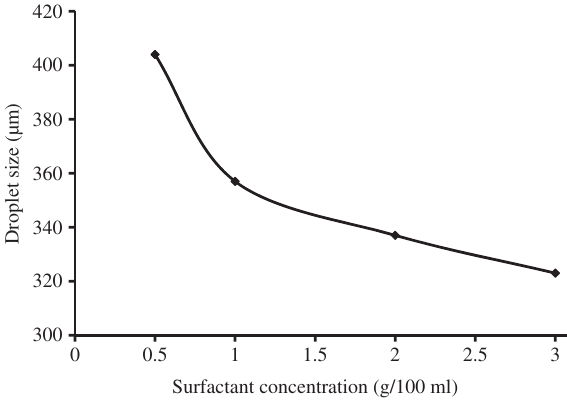
Figure 7: Effect of surfactant concentration on droplet size (flow rate = 2 ml/min, power of atomization = 39 W).